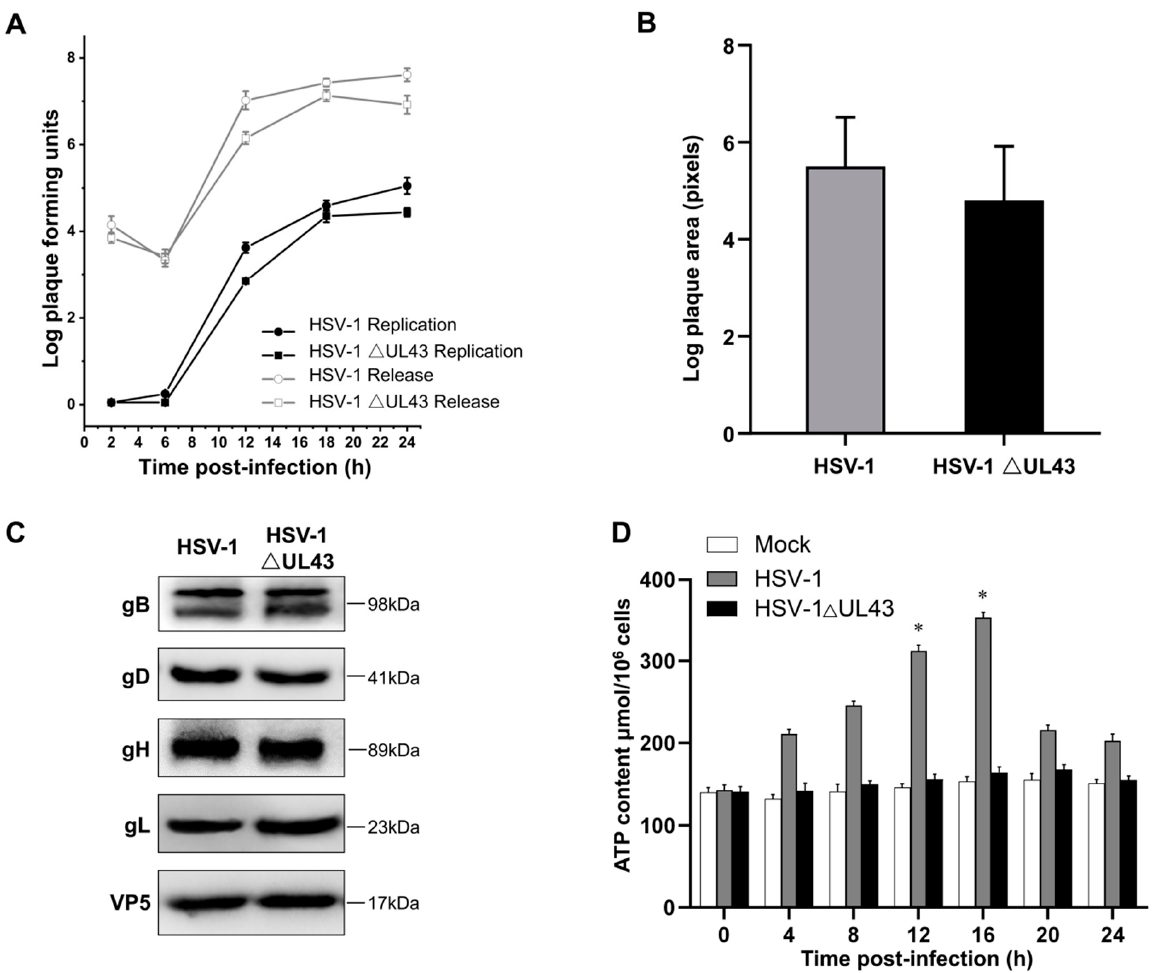
Figure 1. Growth and spread of viruses and viral glycoprotein expression levels in infected cells. ( A ) Single-step growth and supernatant virus curves for HSV-1 and HSV-1 △ UL43 on HUVEC cells. ( B ) Sizes of plaques formed by HSV-1 and HSV-1 △ UL43 on HUVEC cells. Data from one of three representative experiments are shown. ( C ) Western blot analysis of viral glycoprotein expression levels in infected cells. ( D ) ATP content assay of Mock, HSV-1 and HSV-1 △ UL43. *: p < 0.05 vs. other groups.